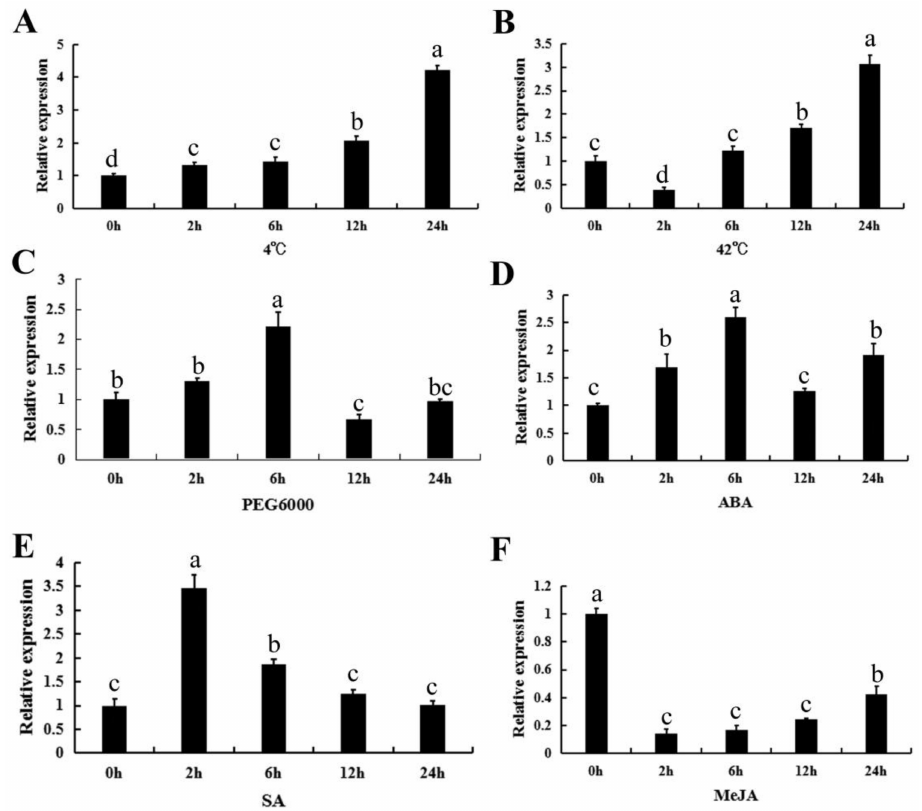
Figure 6. Expression patterns of CpWRKY71 in response to abiotic stress and hormone treatments. Six-leaf stage wintersweet plants were exposed to treatment with ( A ) 4 ◦ C, ( B ) 42 ◦ C, ( C ) 15% PEG6000, ( D ) 50 µ M ABA, ( E ) 2 mM SA, and ( F ) 100 µ M MeJA. CpActin and CpTublin were used as internal control. The RNA was extracted from the top leaves at 0, 2, 6, 12 and 24 h post-treatment. Data represent mean of three biological repeats ± SD. Error bars indicate the standard deviation. Di ff erent lowercase letters indicate significant di ff erences ( p <